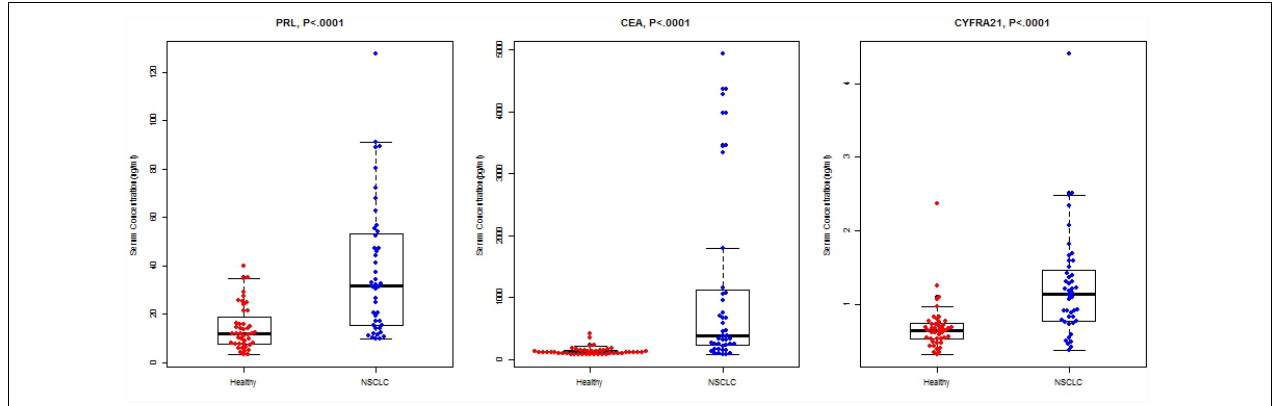
FIGURE 1 | Concentrations of PRL, CEA, and CYFRA21 between NSCLC cases and healthy controls. The bold horizontal lines in the box plots are medians, and the lower and upper limits of the boxes are 25th and 75th percentiles of values, respectively. The P -values were obtained from Mann–Whitney U -test.